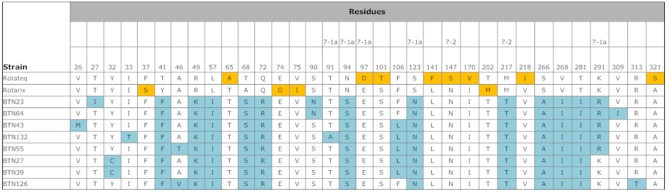
Comparison of the antigenic residues of VP7 present in genotype G1 strains of RotaTeq and Rotarix, and the strains circulating in Bhutan.The respective antigenic epitopes are shown above the residue numbers. The amino acid residues in the Bhutanese strains that differed from those in the vaccine strains are highlighted in blue. The amino acid residues highlighted in yellow indicate that the residue is different from the other vaccine strain and Bhutanese strains.